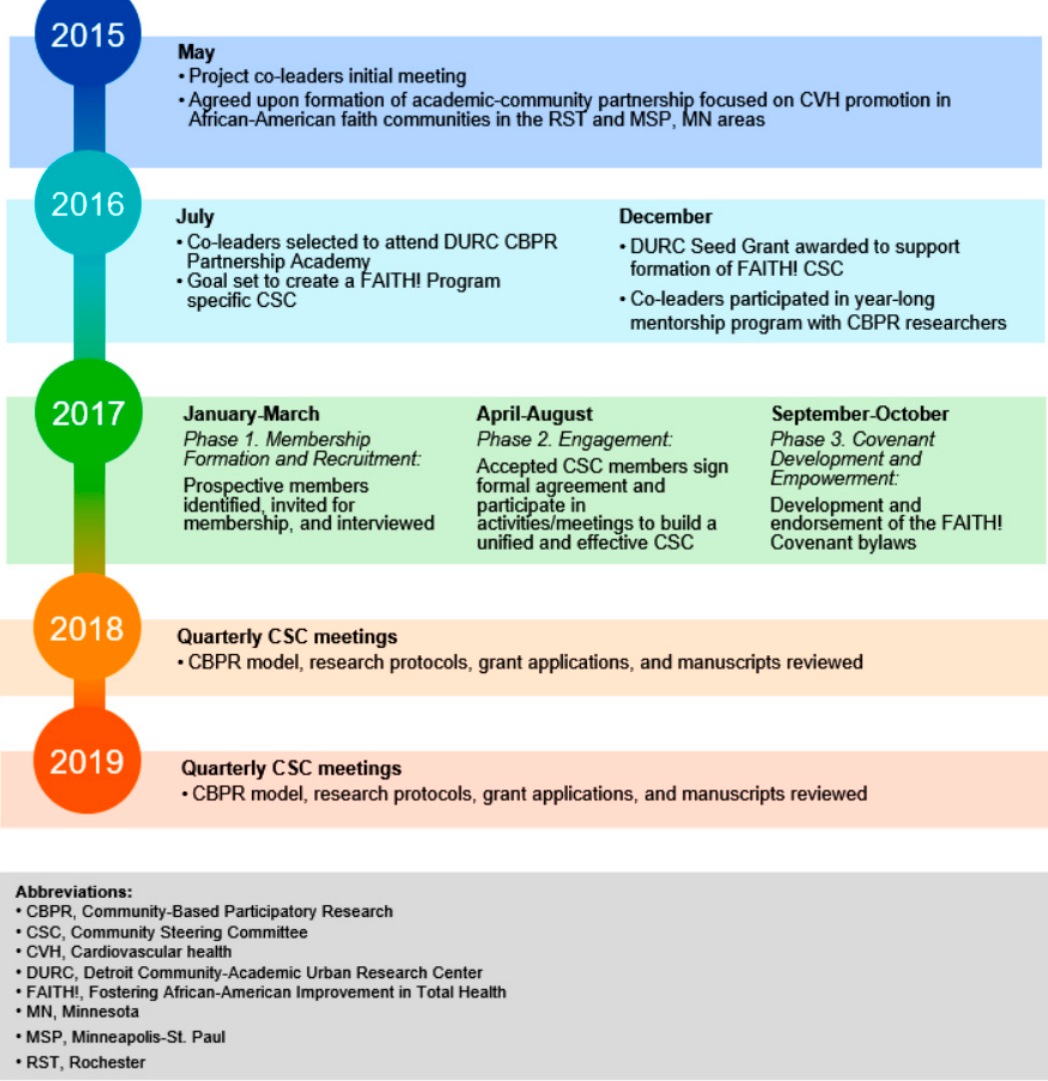
Figure 1. Timeline of FAITH! Community Steering Committee Formation and Implementation.